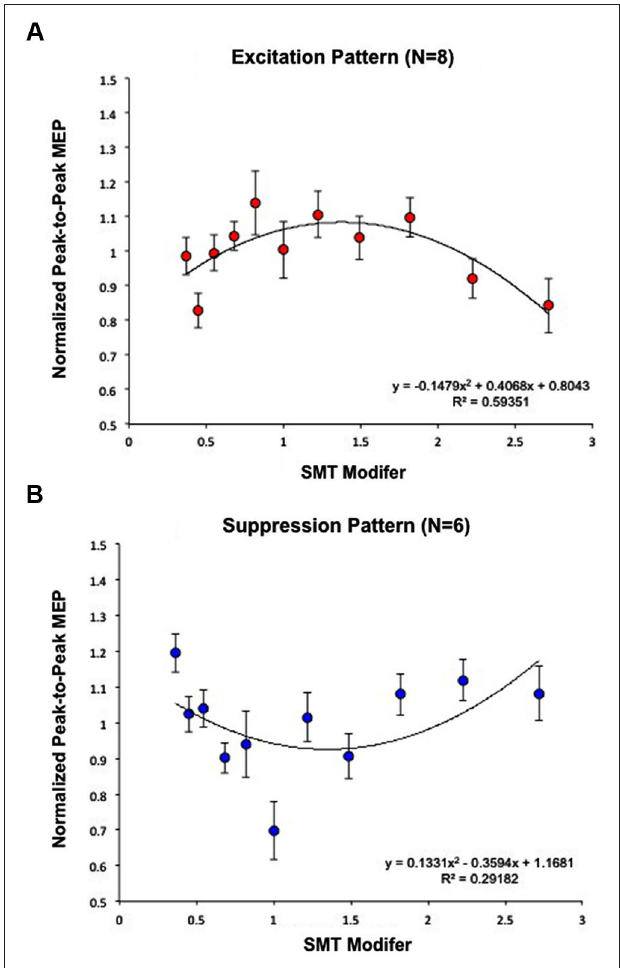
FIGURE 3 | Calculation of effects of PT on MEP modulation . Subjects were analyzed based on the fit of a quadratic model to EMG data and segregated according to the direction of the maximal change in MEP amplitude. (A) Eight subjects were best fit by a negative curve (Excitation Pattern), meaning MEP amplitudes were maximal closest to SMT (1 = SMT). (B) Six additional subjects exhibited a positive curve (Suppression Pattern), meaning MEP amplitudes were minimal closest to SMT. Together, these graphs demonstrate that listening to PT modulates MEP amplitude, but that the direction of change differs across individuals. As in Figure 2B , “SMT modifier” refers to the values that each subjects’ SMT was multiplied by to create the log-spaced tempos of the tone sequences. This means that 1 = SMT, smaller values designate faster tempos, and higher values designate slower tempos. These modifier values were the same for each subject while the actual tempos changed depending on the subjects’